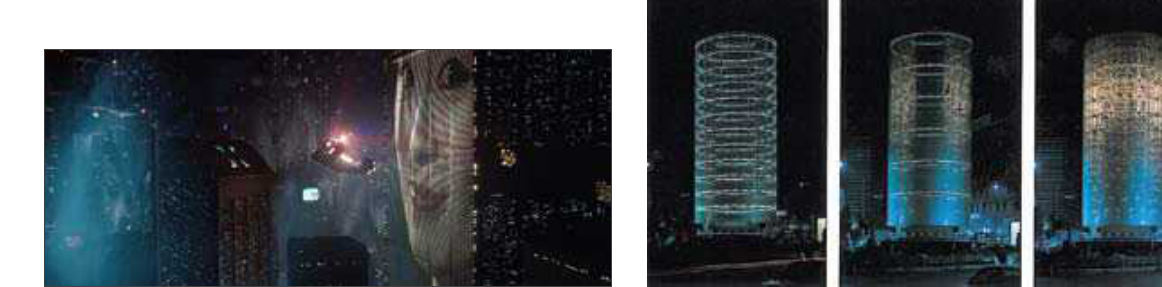
Fig. 10. Media facades in “blade runner”, 1983